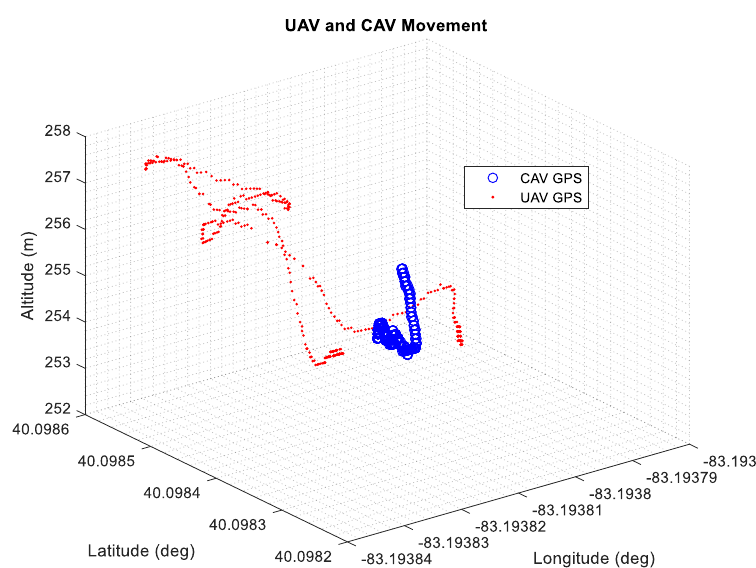
Figure 10. CAV GPS and UAV GPS locations for Experiment #1.